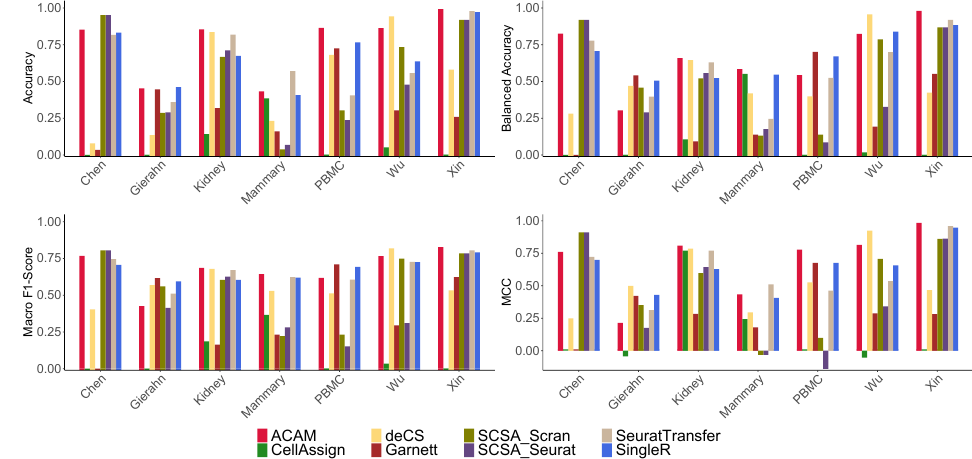
Figure 2. Annotation results comparison. Results of the compared methods using four evalua- tion metrics: accuracy, balanced accuracy, macro F1-score, and MCC on seven real-world datasets are